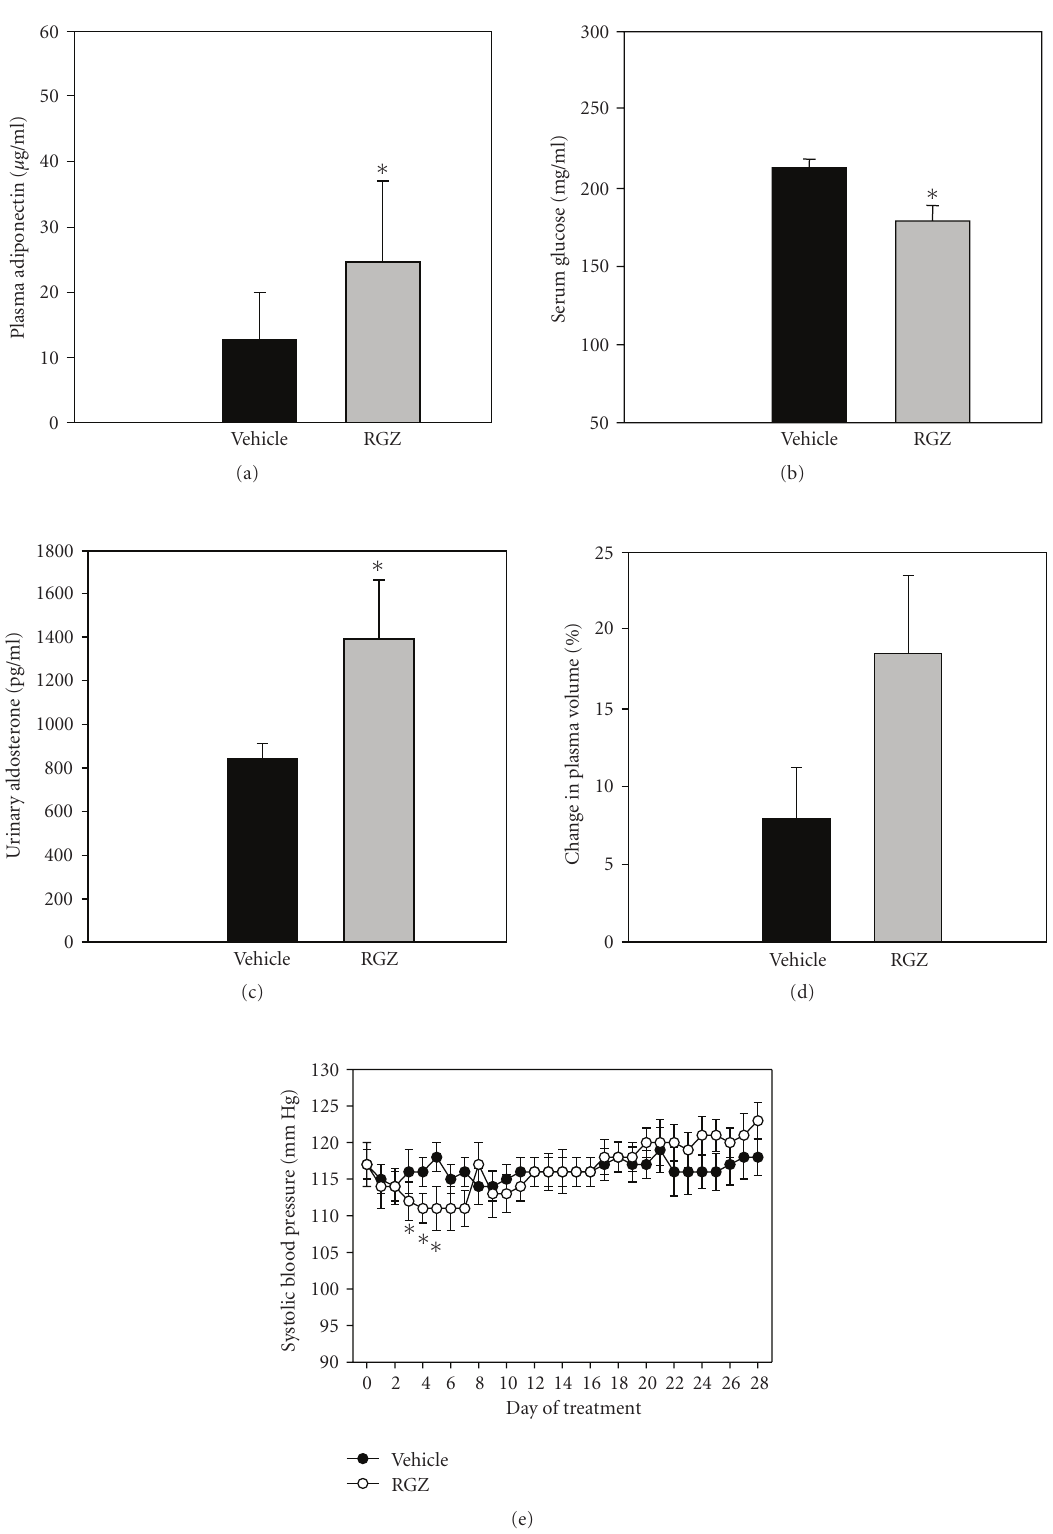
Figure 8: (a) Plasma adiponectin; (b) serum glucose; (c) Urinary aldosterone levels; (d) % Change in Plasma volume; and (e) Systolic blood pressure in normal male SD rats chronically treated with vehicle (VEH) or rosiglitazone at the dose of 80mg/kg · body weight (RGZ), ( n = 10/treatment group). Data were represented as means ± SEM. Means were compared using unpaired t -test. ∗ indicates a significant di ff erence between the groups ( p < 0 .